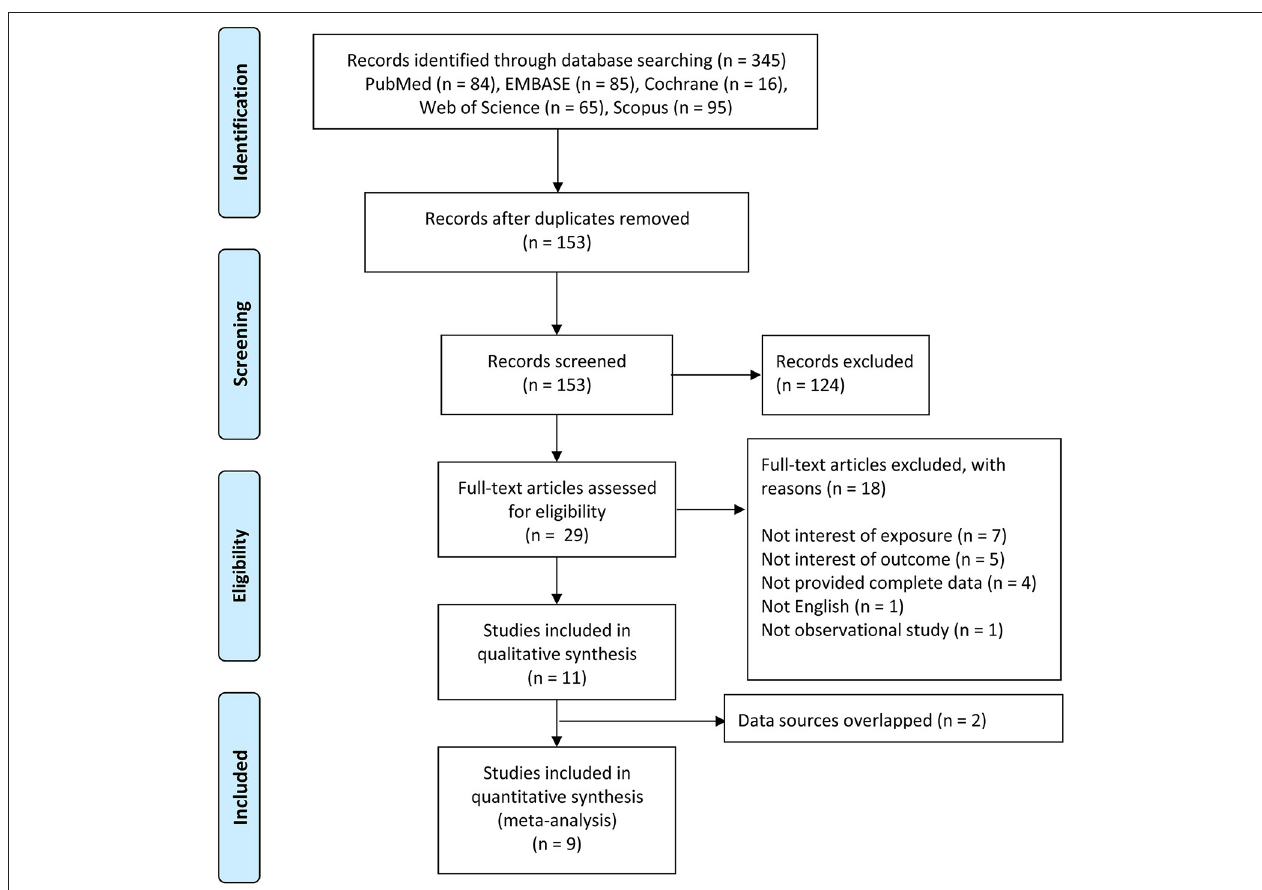
FIGURE 1 | Flow chart of search process and reasons for exclusion.